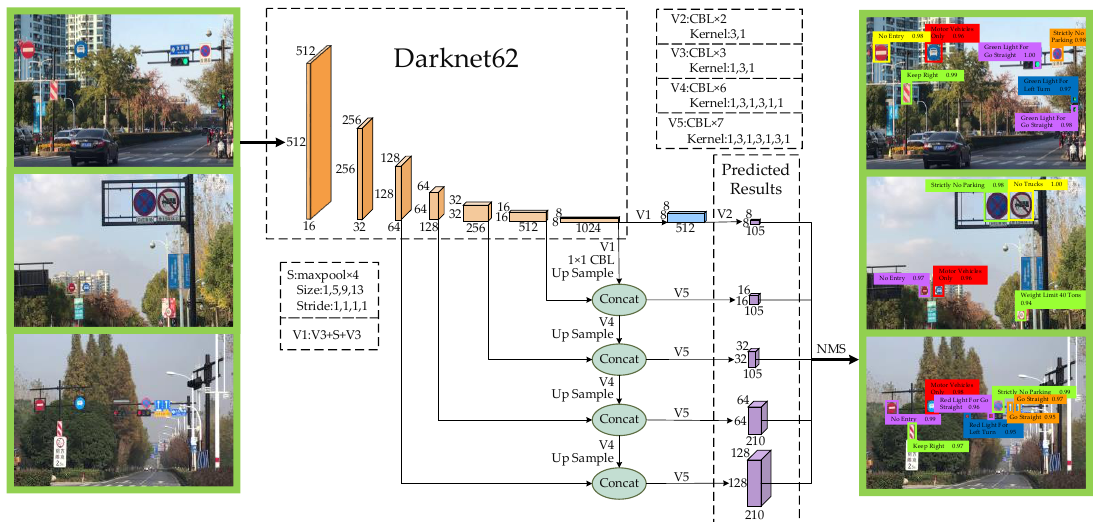
Figure 3. Five-scale recognition network based on FPN. The 128 × 128 × 210 and 64 × 64 × 210 feature maps use small-sized anchors. They have a small receptive field and can have a good recognition effect on small target objects. At the same time, we further improve the performance of the recognition network by up sample and feature fusion.